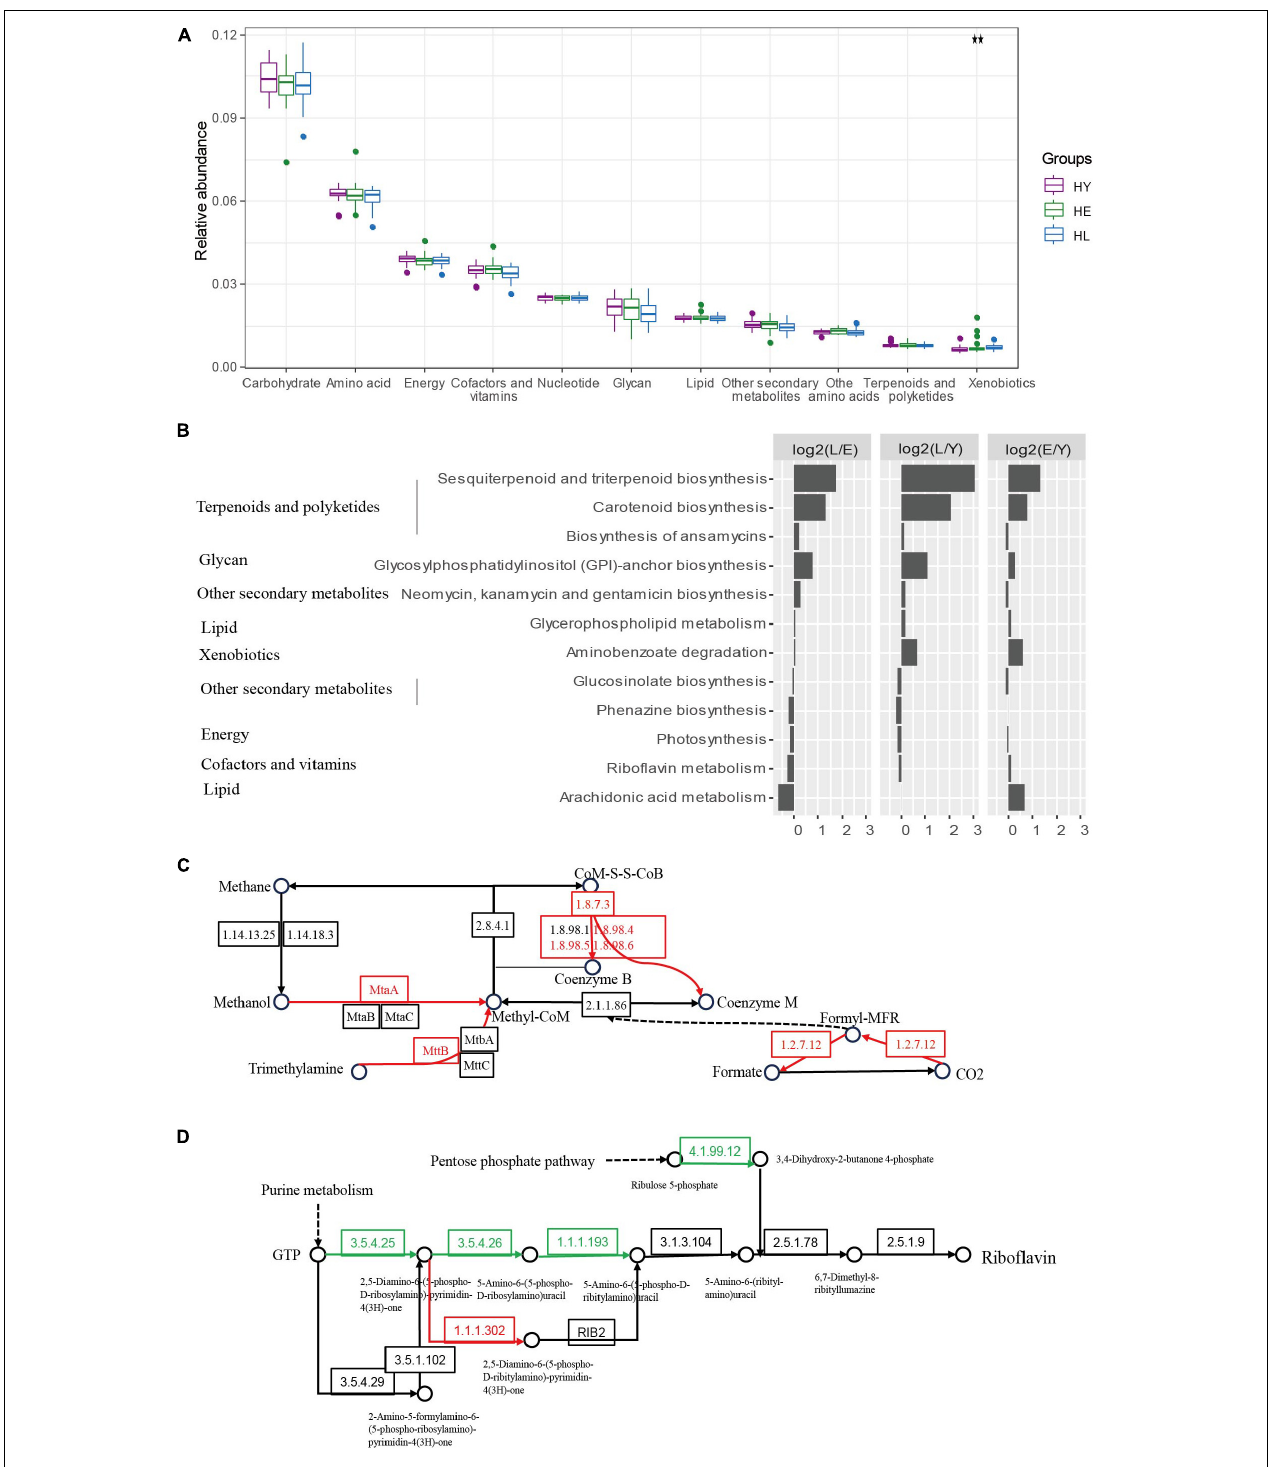
FIGURE 3 | Functional signatures of gut microbiota in the three age groups. (A) Relative abundance of kyoto encyclopedia of genes and genomes (KEGG) metabolic pathways of the microbiome in different age groups (ANOVA). (B) Relative abundance of the gene pathways that are significantly different in the three age groups (ANOVA, P < 0.05). The long-living group compared with the elderly group [HL versus HE (L/E)], the long-living group compared with the young group [HL versus HY (L/Y)], and the elderly group compared with the young group [HE versus HY (E/Y)] are shown in each panel. The length of the bar indicates the base 2 logarithm values of the relative abundance ratios for each age group; 0 represents equal abundance in the two groups. Differences of KEGG orthologous (KOs) in the methane metabolism (C) and riboflavin (vitamin B2) metabolism (D) . HL, long-living people; HE, elderly people; HY, young people.